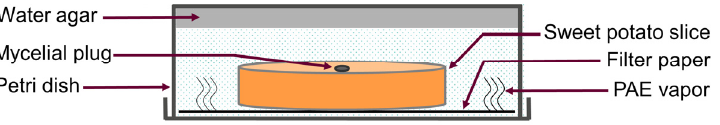
Figure 1. Schema for depicting the assay method determining the effect of PAE on sweet potato